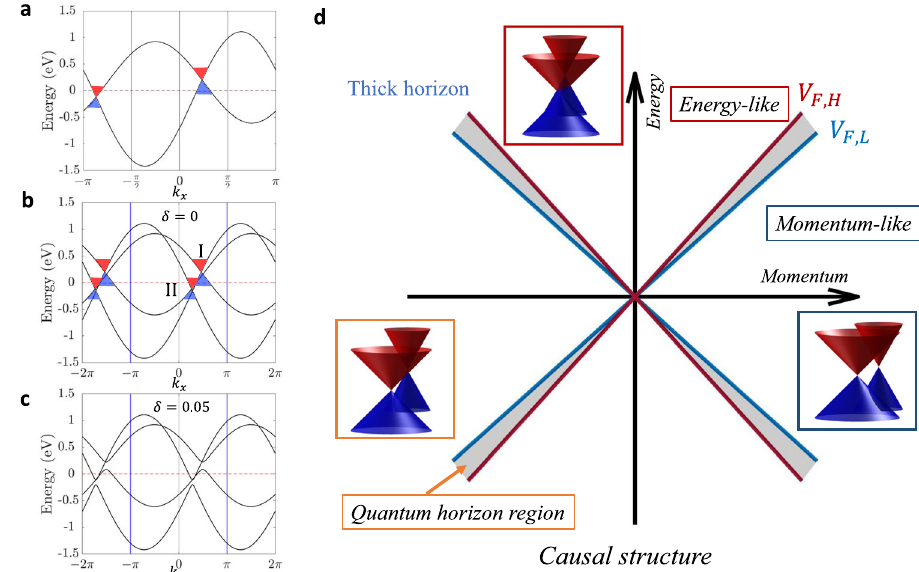
Fig. 4 | Causal structures with quantum horizon region. a – c Band structure asa function of k x with A =0.3, θ =1, k 1 =1.1 π /2, k y =0, and k z = π /2. a Without CDW, the FermivelocitiesofthetwoWeylquasiparticlesaredifferent. b WithoutCDW( δ =0), the folded bandsinthe doublesupercellBZalong the x-direction. The Weyl nodeI isintheenergy-likeregionofWeylnodeIIbutWeylnodeIIisinthemomentum-like